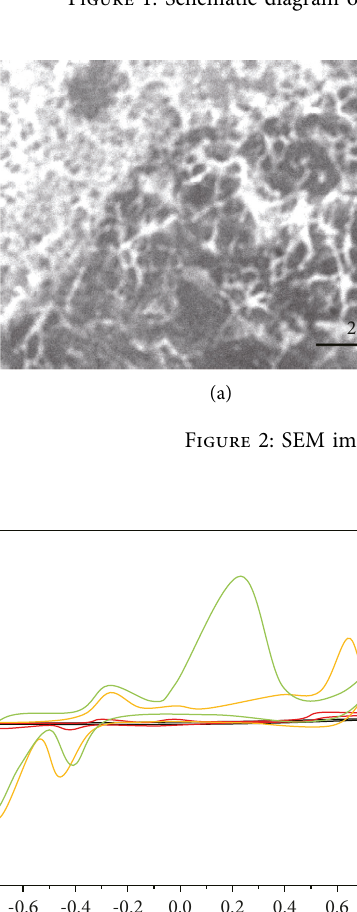
Figure 1: Schematic diagram of the preparation of CuNW/SPCE for UA detection.